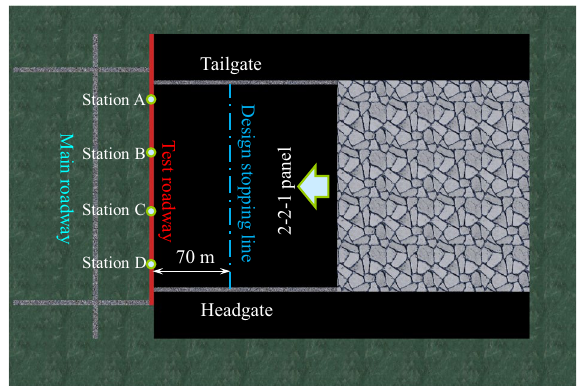
Figure 2. Roadway layout.